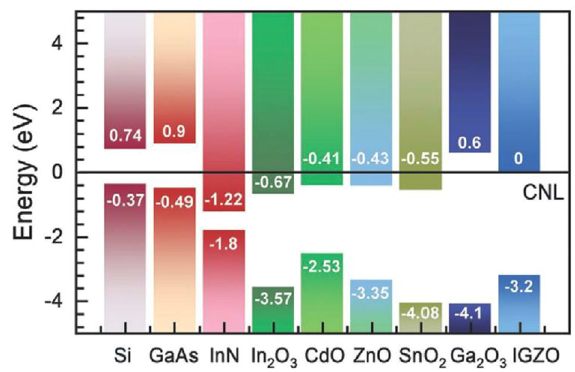
Fig. 11 Band lineups of oxide semiconductors and other conven- tional semiconductors